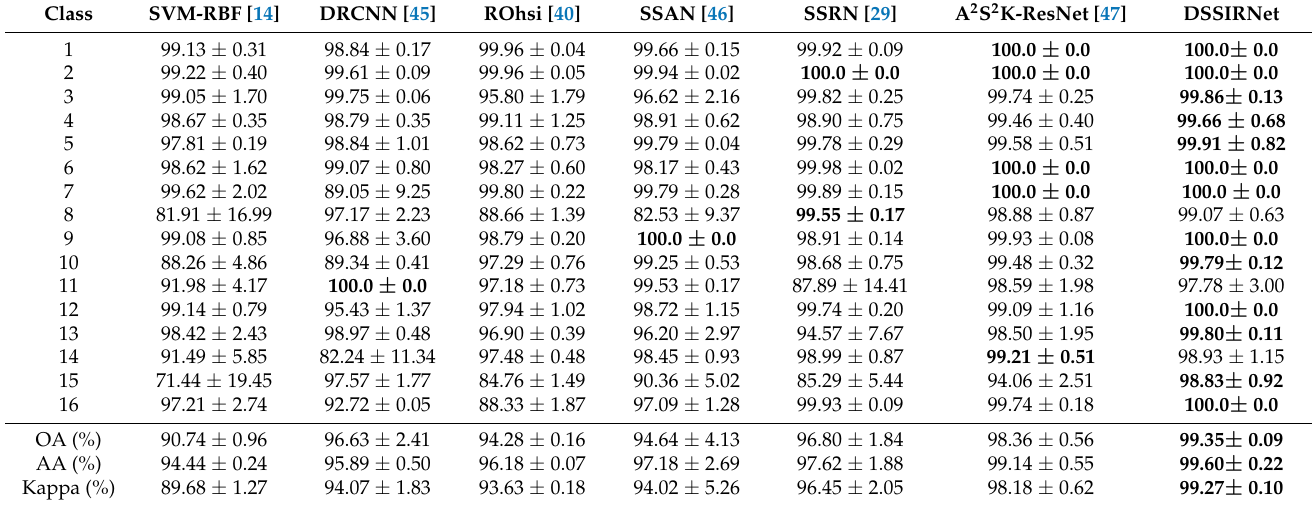
Table 5. Classification results of different methods on the SV